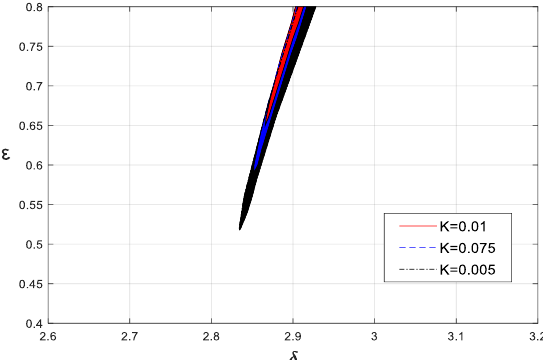
Figure 20. The effects of K on the 6T -resonance line.